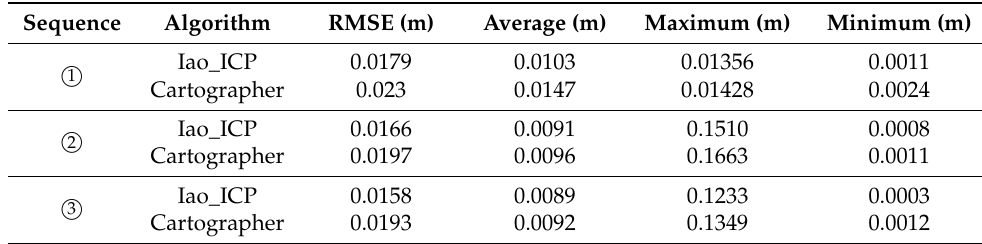
Table 1. Comparison results of absolute trajectory error between Iao_ICP algorithm and Cartographer algorithm.